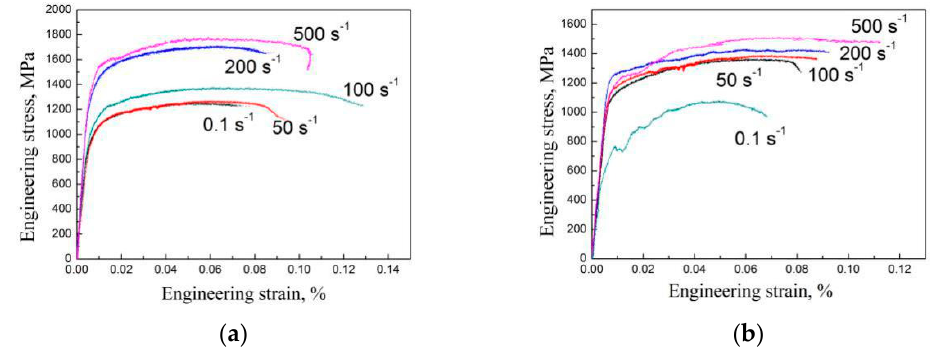
Figure 5. Engineering stress-strain curves of the quasi-static and the dynamic tensile tests of ( a ) B3 and ( b ) Q&P treatment samples. Table 3. Dynamic tensile properties of samples with different heat treatments. Ultimate tensile strength (UTS), total elongation (EI), and the product of the tensile strength and the total elongation (UTS × EI). B3 Strain Rate, s − 1 UTS,